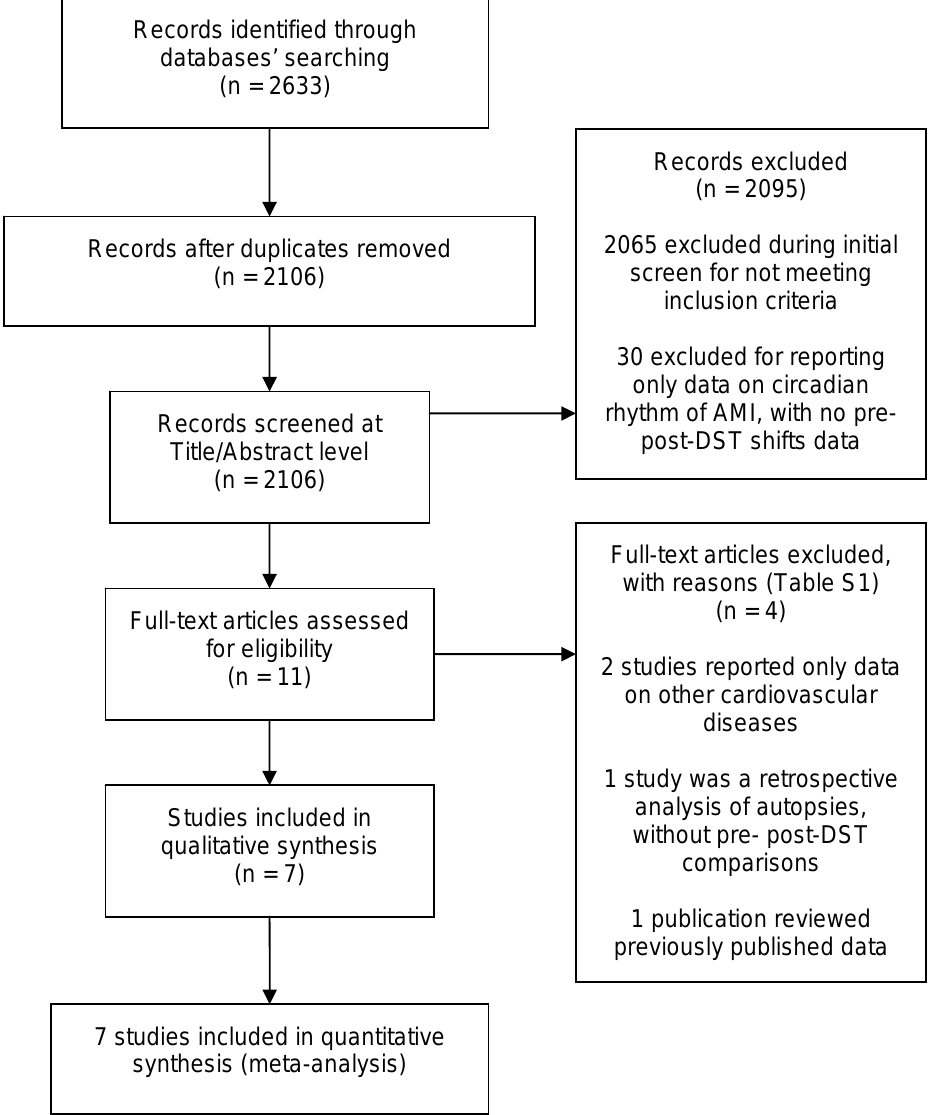
Figure 1. Flow of the included studies in each stage of the bibliographic